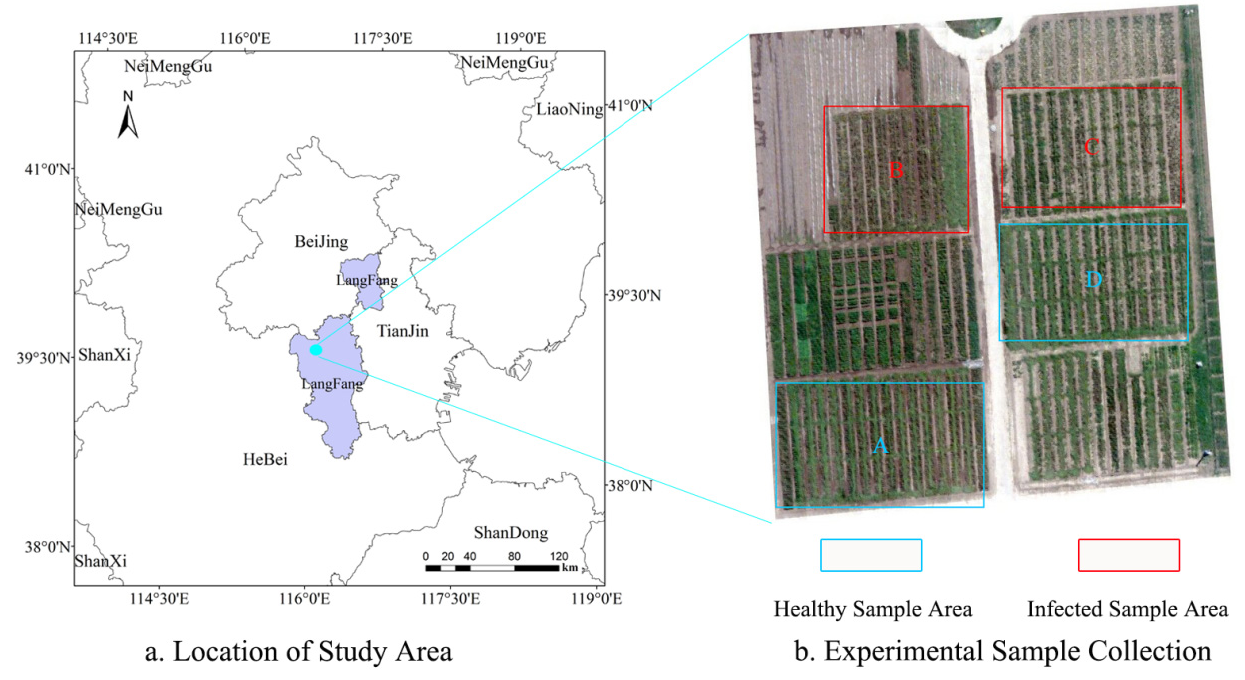
Figure 2. Study area. ( a ) Location of the study area; ( b ) Experimental plots.